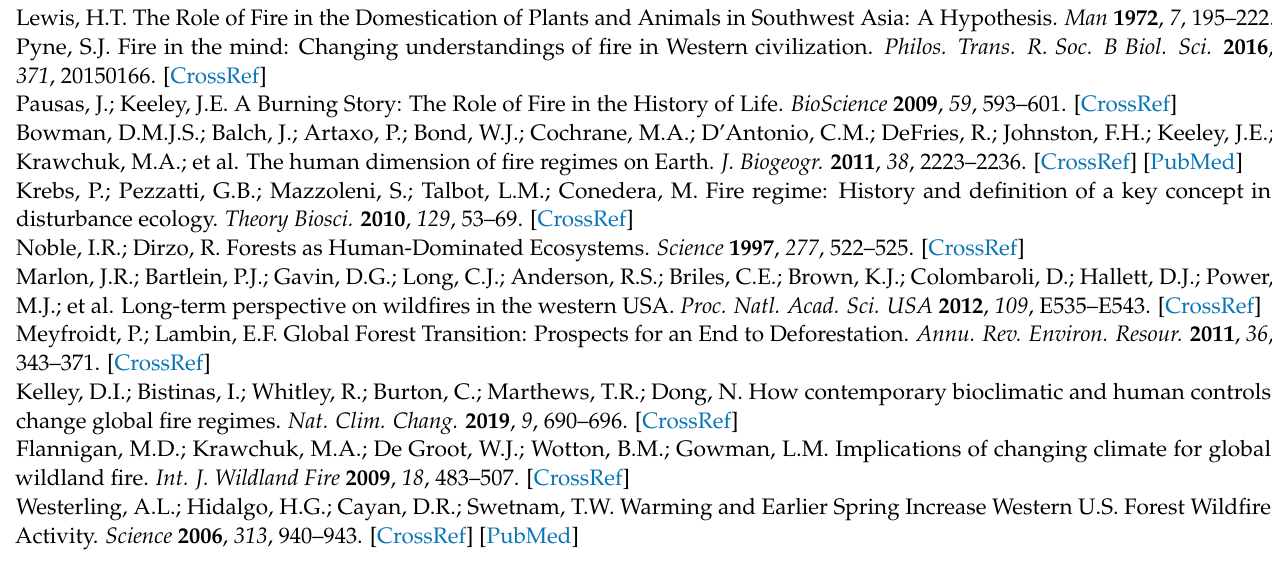
Table S2: efficacy level as firebreaks by intervention; Table S3: class values for risk index components in each